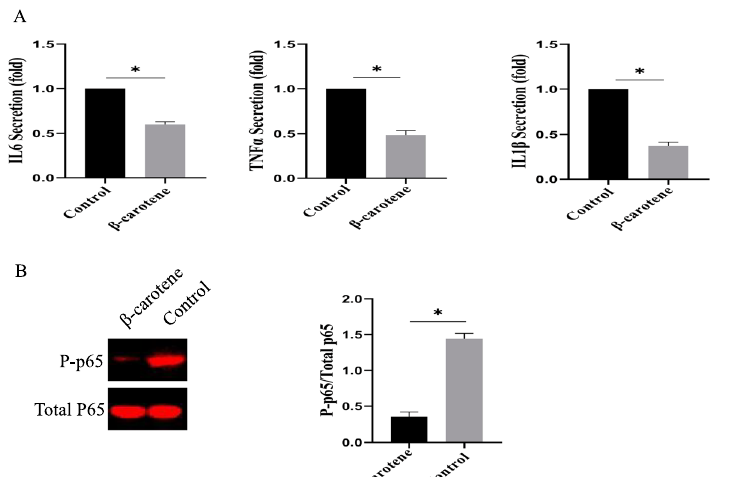
Fig. 7 The effect of β-carotene on inflammation in vitro. A The effect of β-carotene on the aging-induced inflammation in Ad-MSCs and Bm-MSCs. n 3 biological replicates. B The effect of β-carotene on NF-κb = expression. Data are expressed as mean SD. The asterisk indicates a significant difference (p < ±